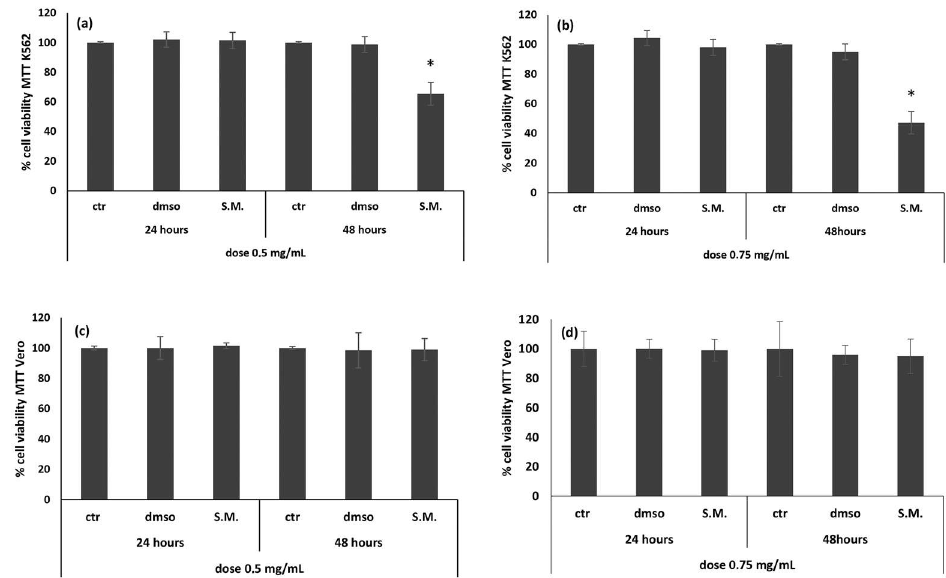
Figure 1. Effect of Skeletonema marinoi (S.M.) on Vero ( c , d ) and K562 ( a , b ) cells viability. MTT test was performed at 24 h and 48 h, using two different concentrations of S.M. (0.5 and 0.75 mg/mL). Data are expressed as a percentage of the cell viability, and results are expressed as the mean ± standard deviation (SD) of three experiments. Statistical differences between control and S.M. were evaluated by one-way analysis of variance (ANOVA), followed by Tukey’s posttest (* p < 0.05 versus ctr/dmso cells).